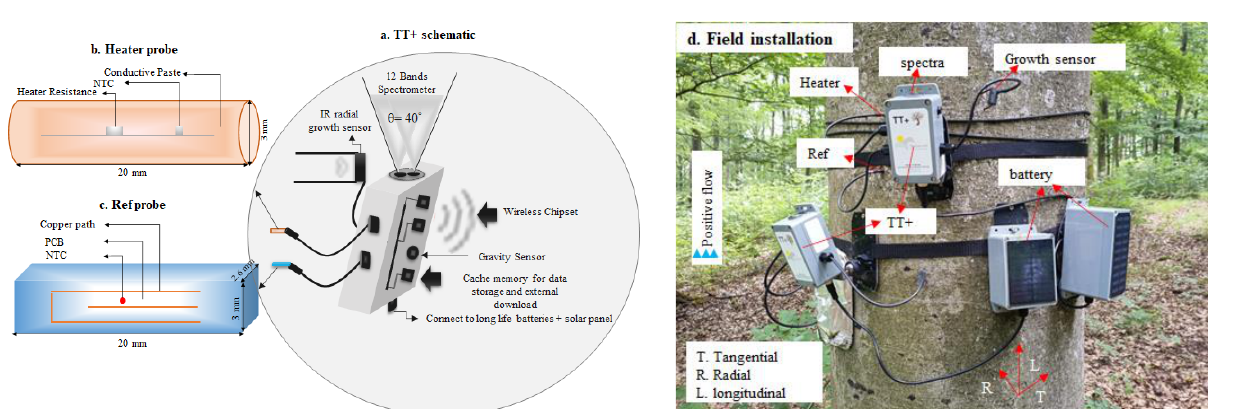
Figure 1. ( a ) TT+ layout, ( b ) Heater probe including a thermistor (NTC) and a heater resistance, which are placed in a conductive paste, ( c ) Ref probe including a thermistor (NTC) and a copper path as a capacitance oscillator, and ( d ) installation of two TreeTalkers (TT+) on a beech